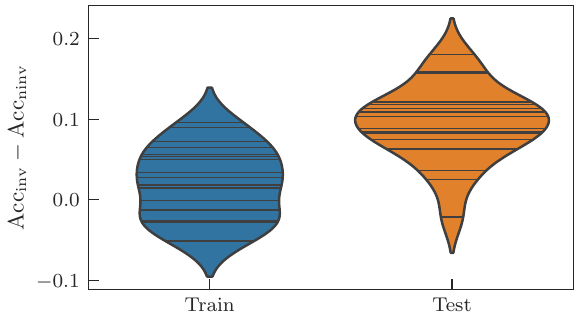
FIG. 4. Violin plot of the difference in achieved mean accu- racies between the invariant and noninvariant models in a sweep over different values of l and p as detailed in the text. Positive val- ues correspond to invariant models outperforming noninvariant ones. The mean is averaged over ten runs for each combination of l and p . We see that the mean accuracy on the training data is more or less the same for both invariant and noninvariant models, but that the invariant models clearly outperform the noninvariant ones on the test data. The magnitude of the difference compares well to the absolute test accuracies of both models that, depend- ing on l and p , lie between 0.59 and 0.80 (invariant) and 0.48 and 0.62 (noninvariant), significantly larger than the random guess- ing probability 0.33. The full training graphs are given in Fig. 14 in the Appendix.